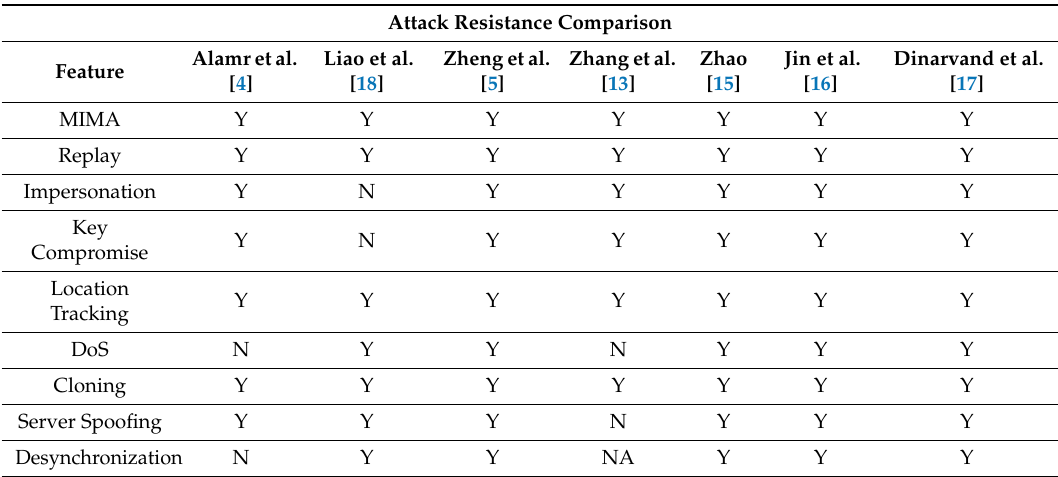
Table 5. Comparison of each protocol’s resistance to various